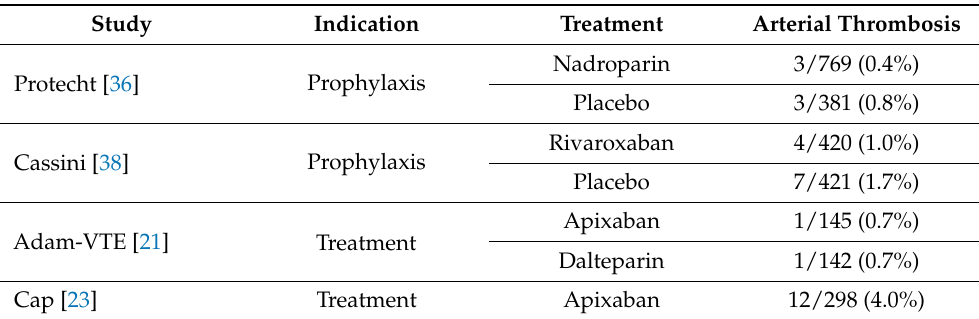
Table 9. Arterial thrombosis in cancer patients receiving